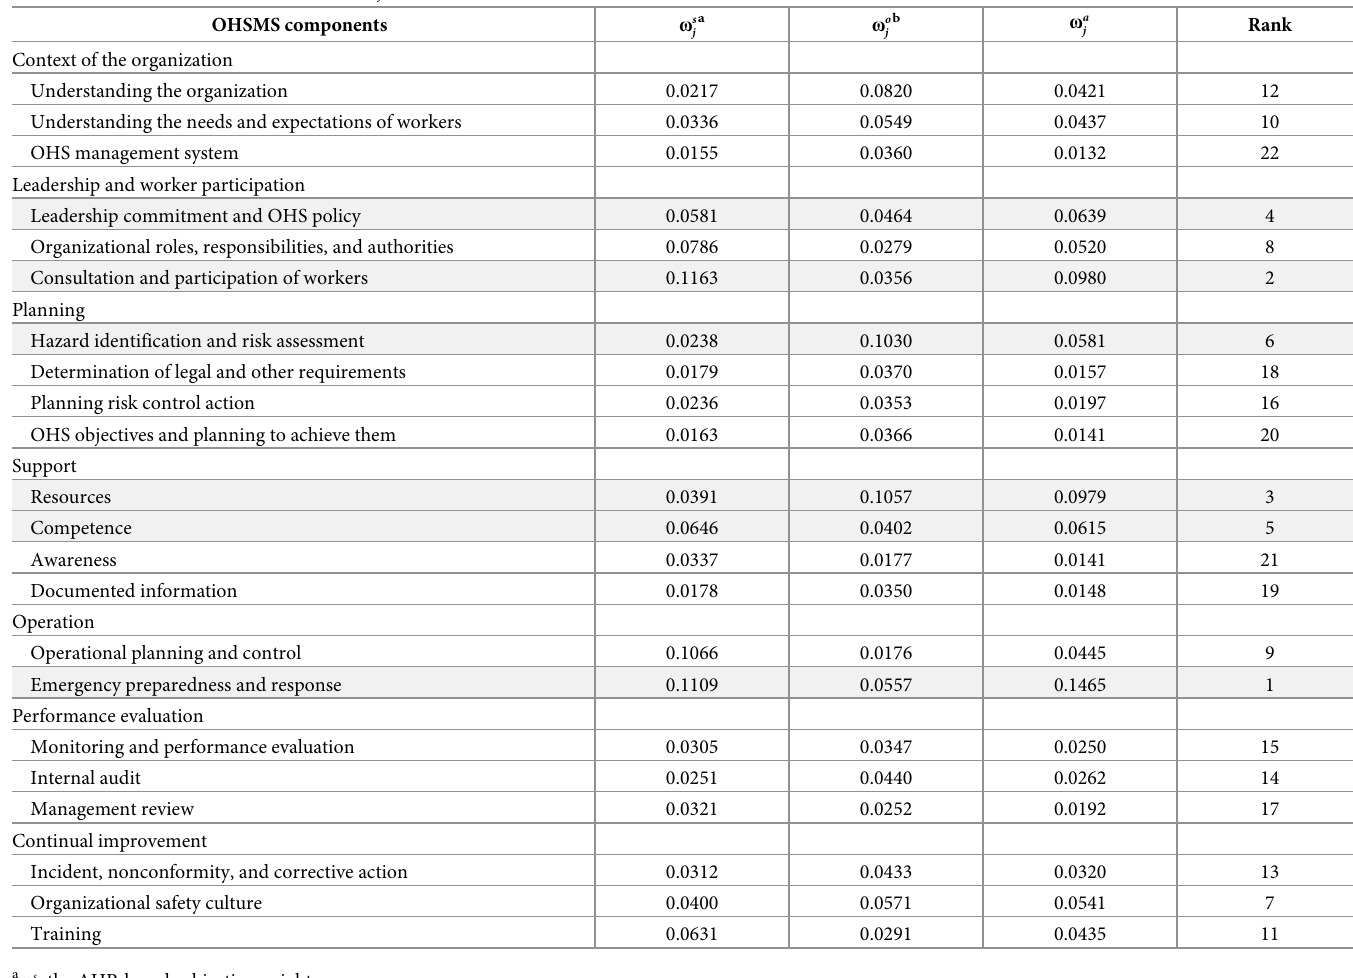
Þ and priorities of OHSMS components through AHP-entropy j